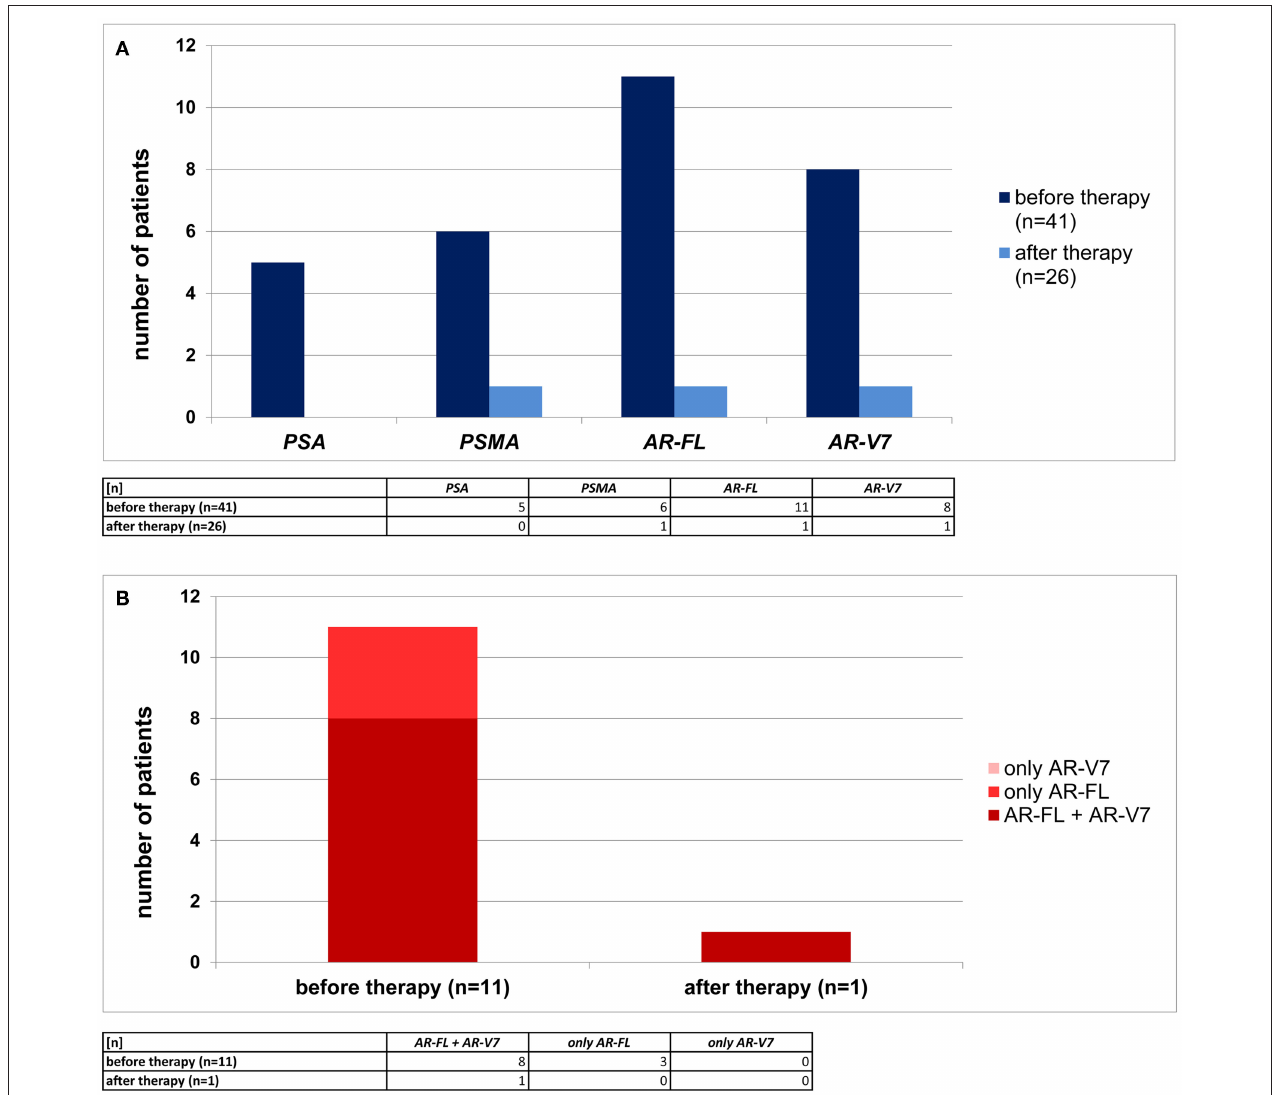
FIGURE 1 | Prevalence of primary TNBC patients with prostate cancer related transcripts detected in CTCs. (A) In 41 TNBC patients before therapy (dark blue) and 26 TNBC patients after neoadjuvant therapy (light blue) PSA , PSMA , AR-FL , and AR-V7 RNA profiles were examined. (B) Co-expression of AR-FL and AR-V7 (dark red) was detected in the majority of AR-FL + CTCs. Some patients displayed only AR-FL + CTCs (red), but no patient was examined to have only AR-V7 + CTCs (light